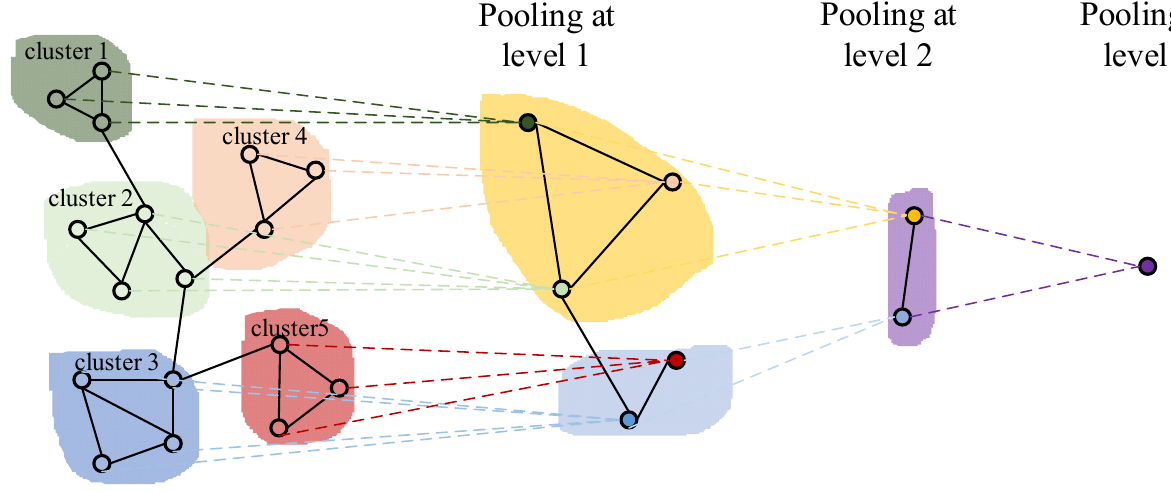
Figure 4. Three-layer pooling process.